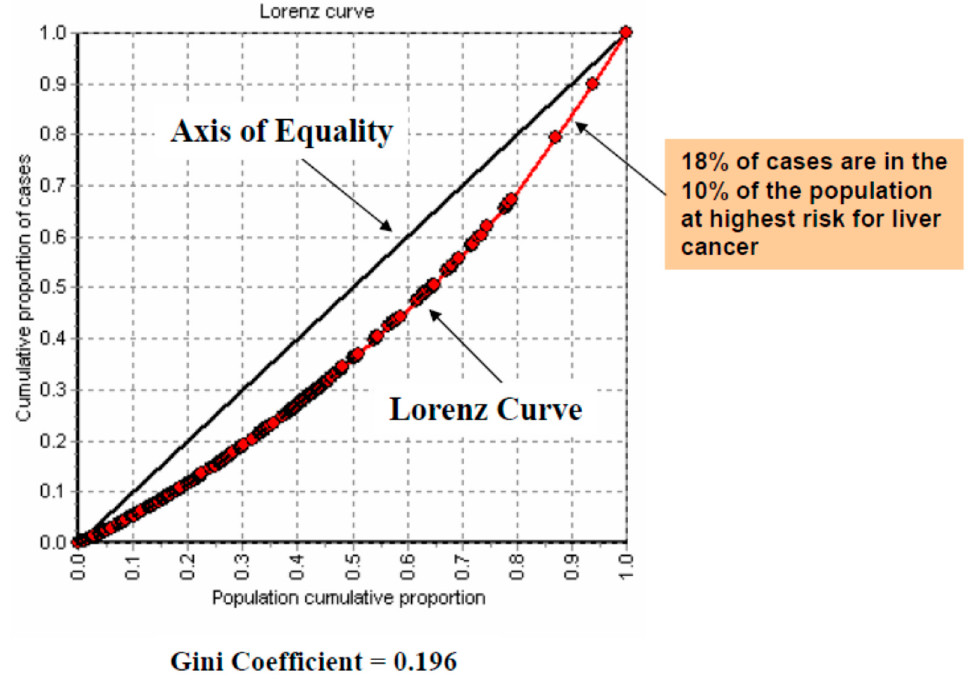
Figure Figure 4. The Gini coefficient describes the degree to which cases are distributed equally in relationship to the population at risk.